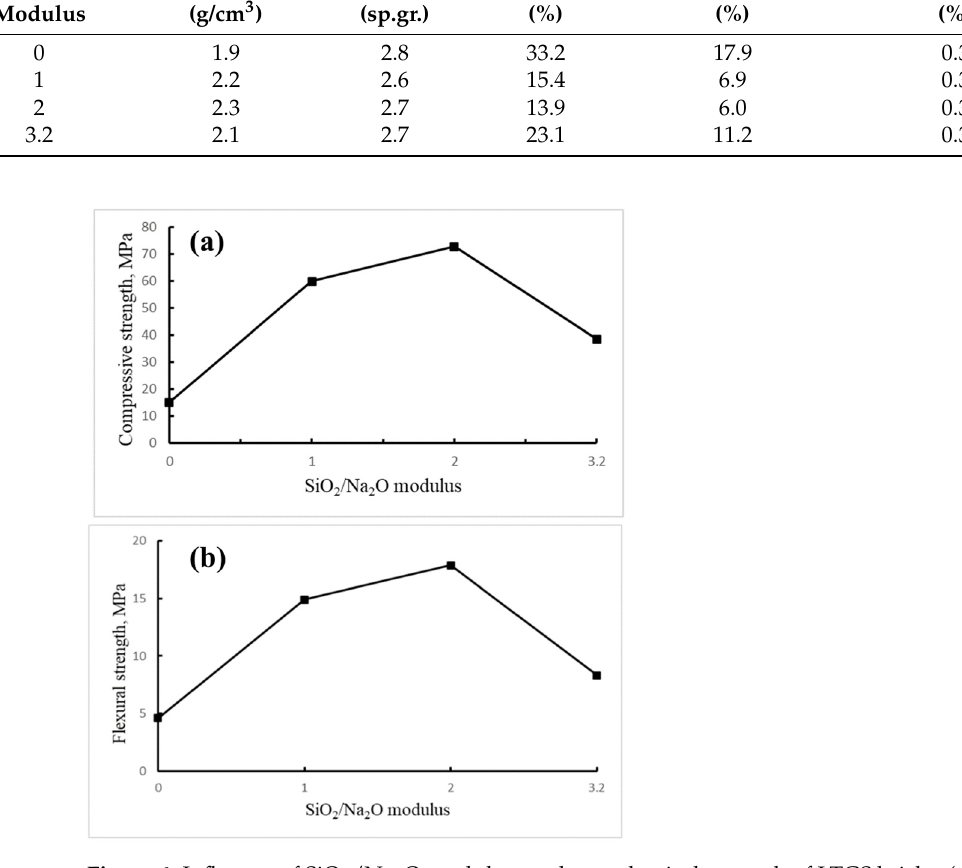
Figure 6. Influence of SiO 2 /Na 2 O modulus on the mechanical strength of LTGS bricks, (a) compres- sive strength (b) flexural strength.